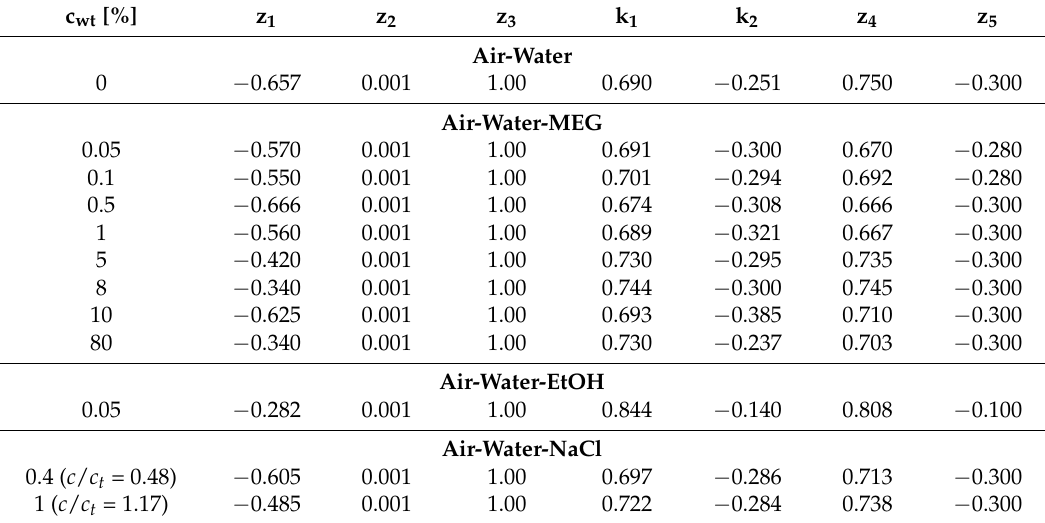
Table 7. Coefficients for aspect ratio correlation (Equation